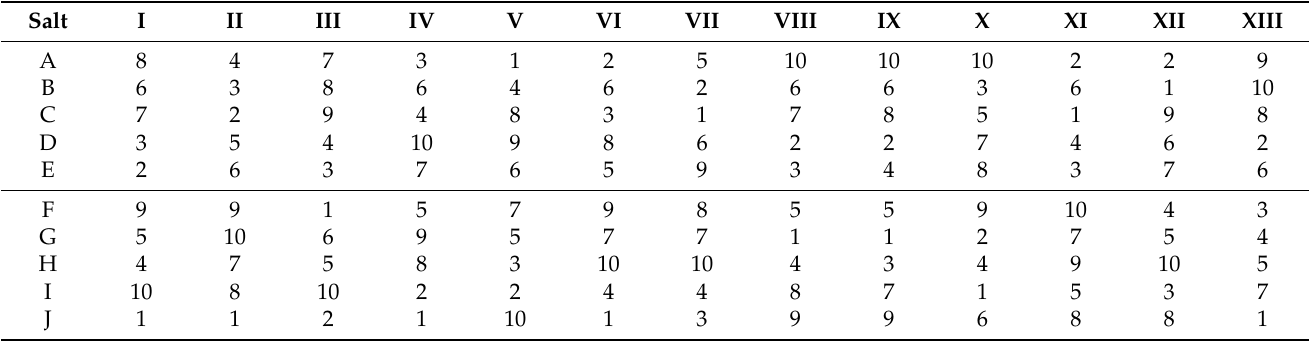
Table 4. Summary table of increasing degree of utility of